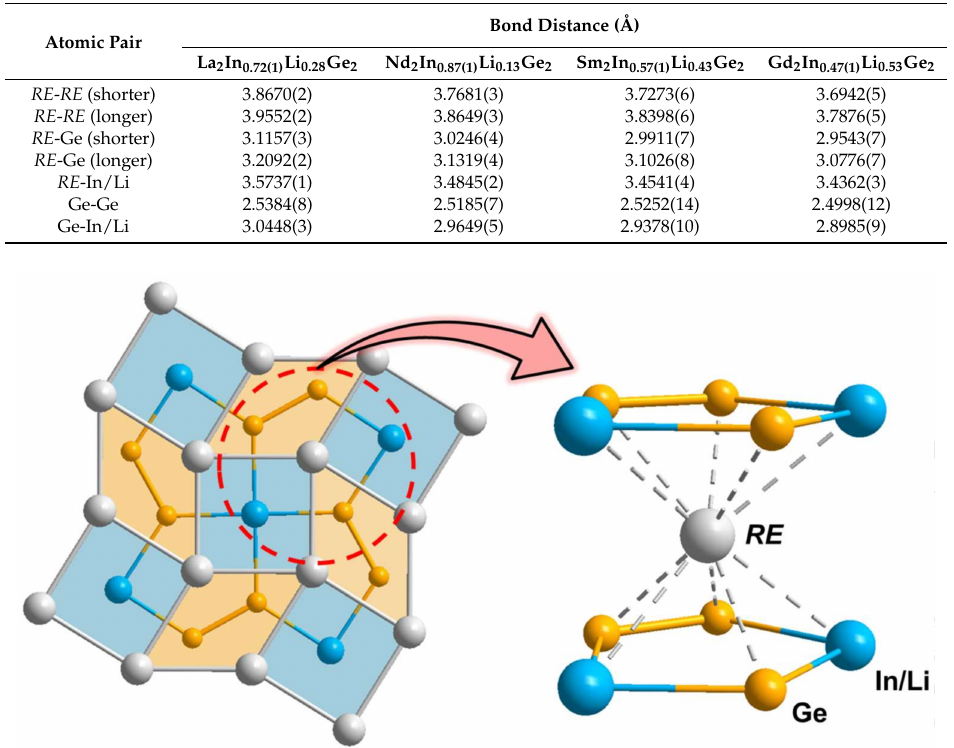
Table 3. Selected interatomic distances (Å) for the RE 2 In 1 − x Li x Ge 2 ( RE = La, Nd, Sm, Gd; x = 0.13(1),